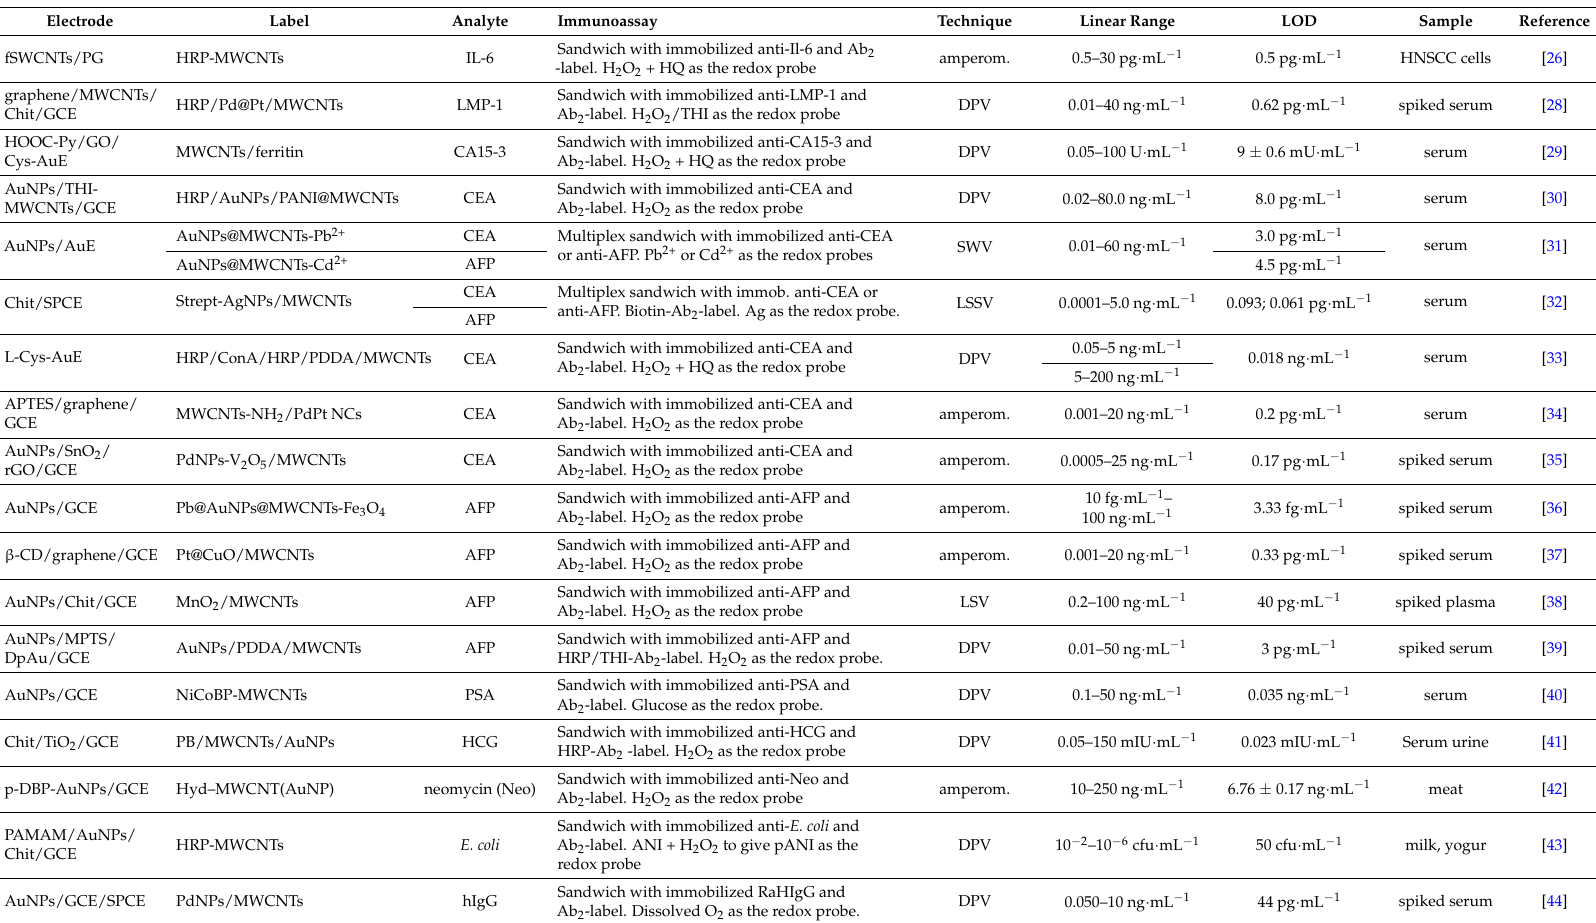
Abbreviations: ANI, aniline; APTES, 3-aminopropyltriethoxysilane; CEA, carcinoembryonic acid; Chit, chitosan; ConA, concavalin A; DpAu, porous deposited gold nanocrystal; fSWCNTs, forest SWCNTs; GA, glutaraldehyde; Hyd, hydrazine; L-Cys, L-cysteine; mIU: milli-international units; MPTS, 3-mercaptopropyl) trimethoxysilane, PAMAM, polyamidoamine; p-DBP, poly-[2,5-di-(2-thienyl)-1 H -pyrrole-1-( p -benzoic acid)]; pANI, poly(aniline); PDDA, Poly(diallyldimethylammonium); PG, pyrolytic graphite; RaHIgG, rabbit anti-human IgG antibody; THI,